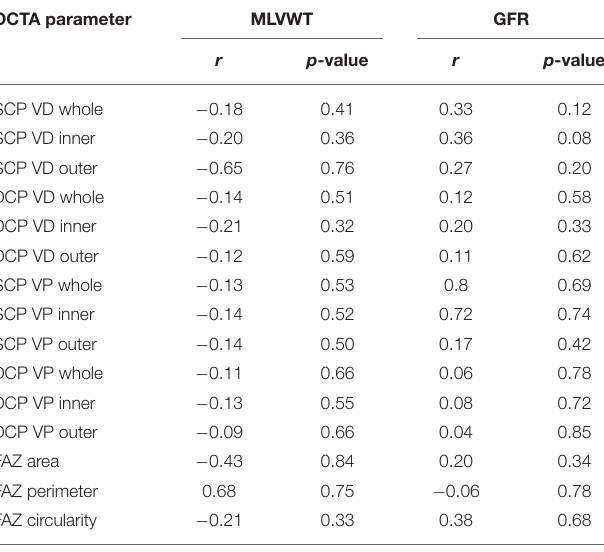
TABLE 3 | Correlation between OCTA parameters and systemic parameters in patients with Fabry disease. OCTA